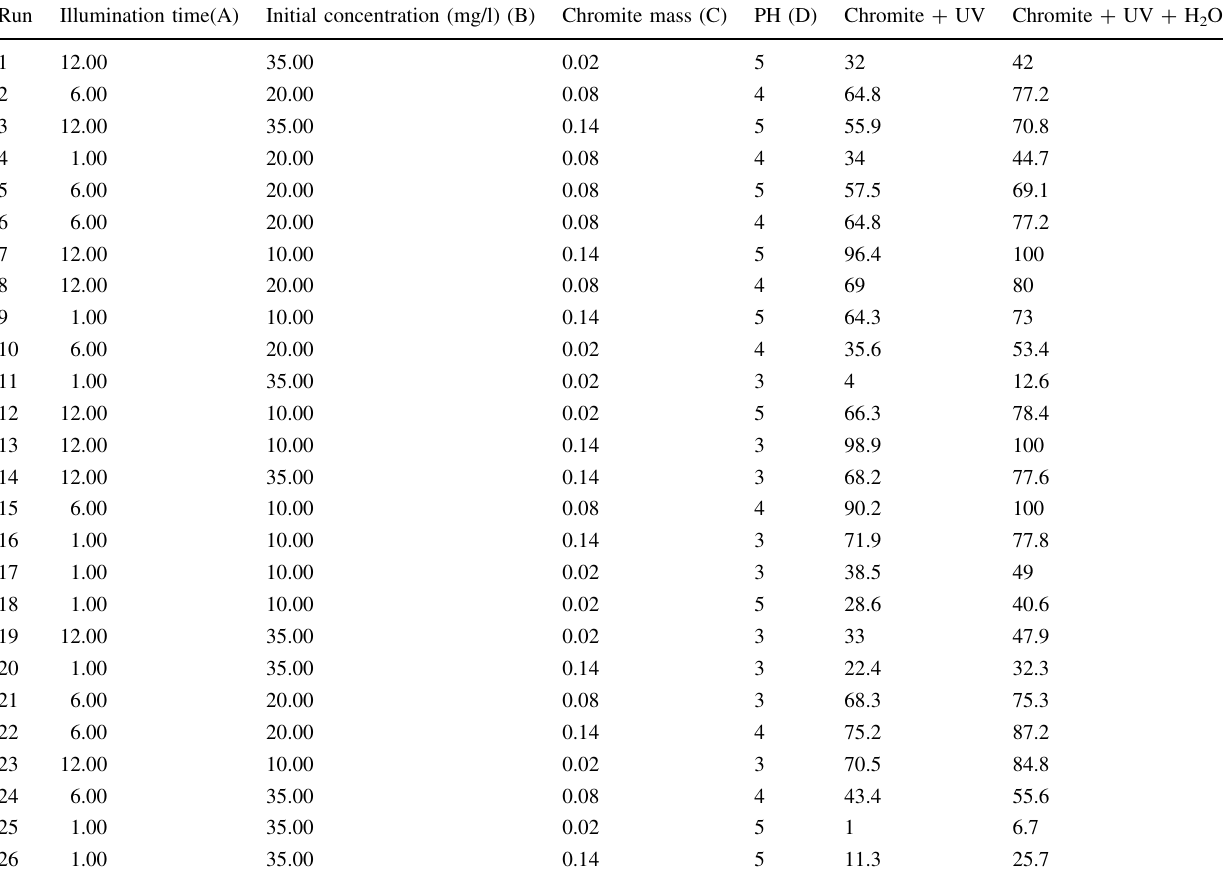
Table 4 Results of the experimental runs designed according to the CCRD Run Illumination